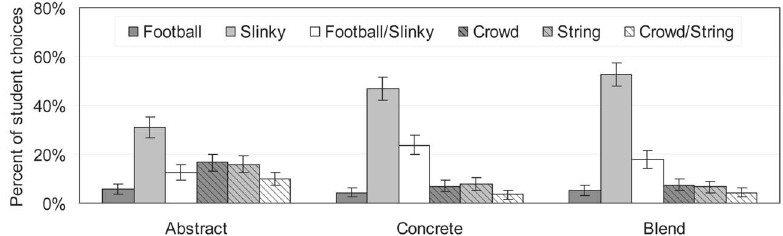
FIG. 11. Percent of students in the abstract, concrete, and blend groups choosing single analogies (cid:1) football, slinky, crowd, string (cid:2) or two analogies (cid:1) football/slinky, crowd/string (cid:2) . Other combinations accounted for less than 8% of student